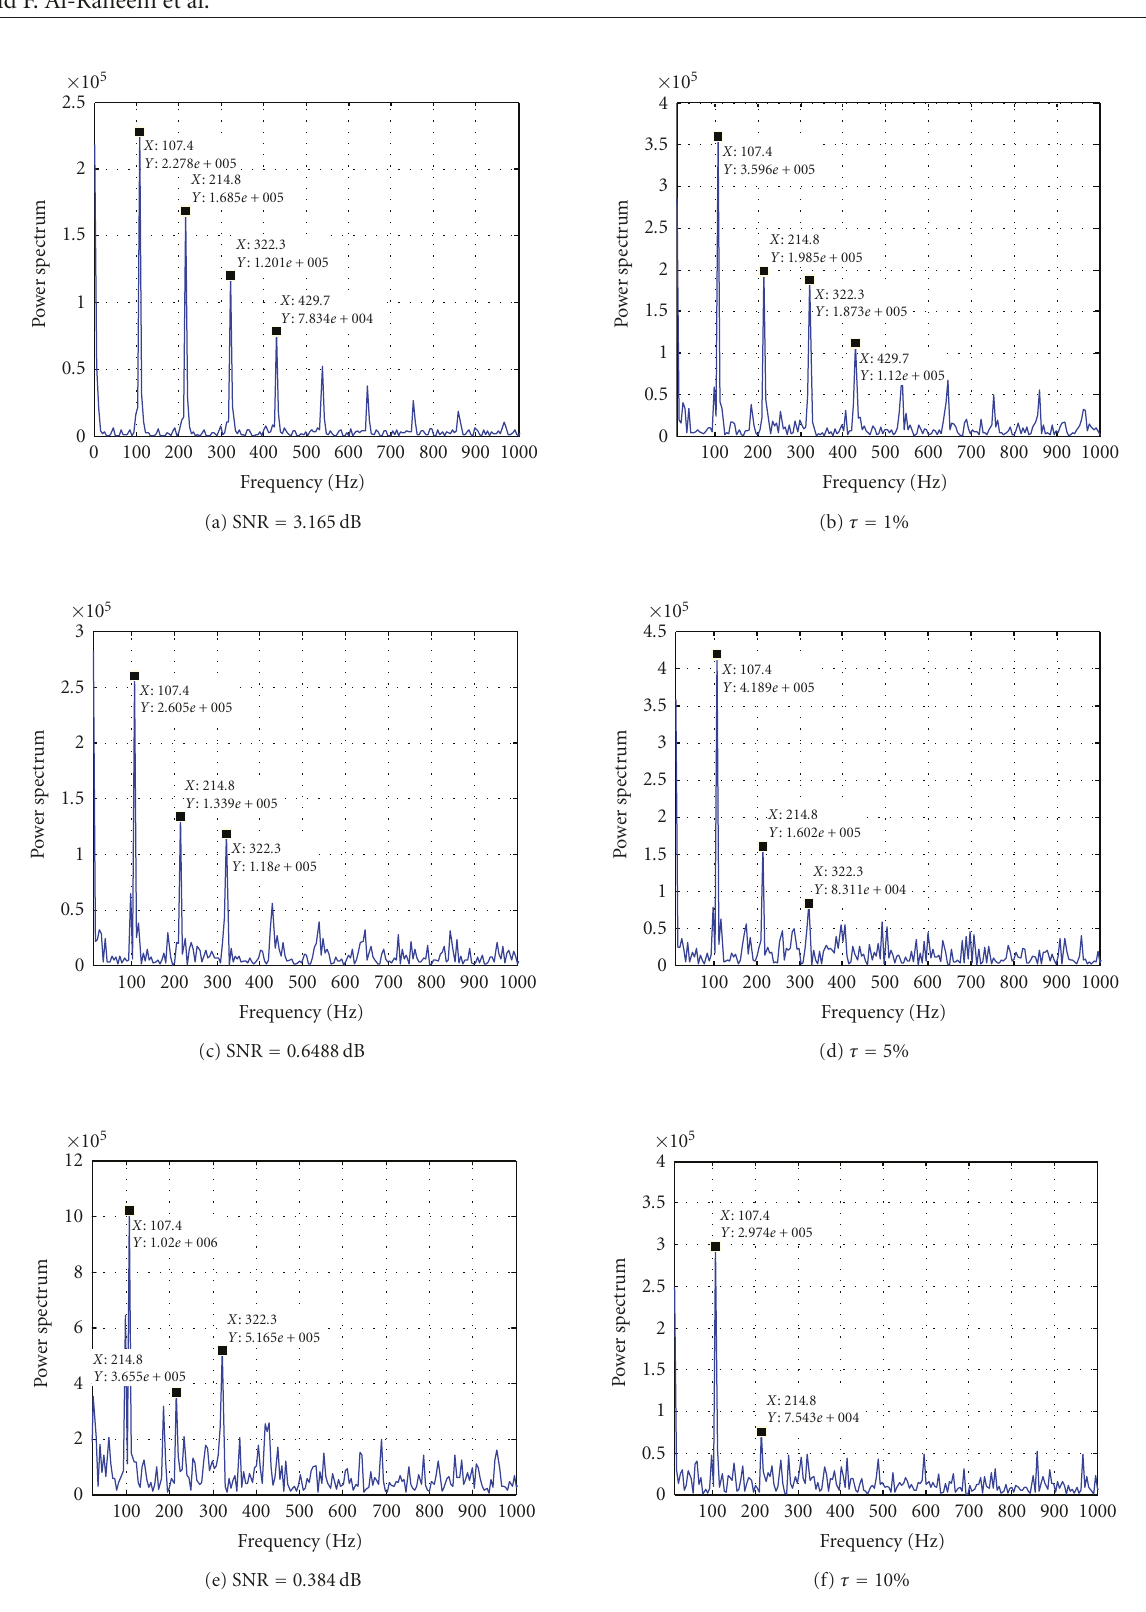
Figure 8: The TWPS for bearing with outer-race fault for di ff erent (left column) SNR and (right column) slip variation ( τ